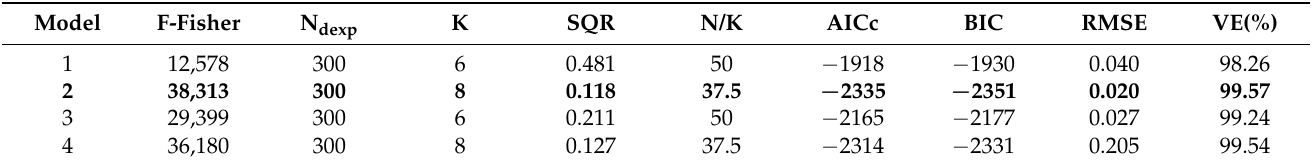
Table 6. Goodness-of-fit statistical data at 95% confidence for the proposed kinetic models to fit to the triphasic glycerol-toluene(+ibuprofen)-N435 data (fitting each model to all retrieved data). In bold font, data related to the selected model: model